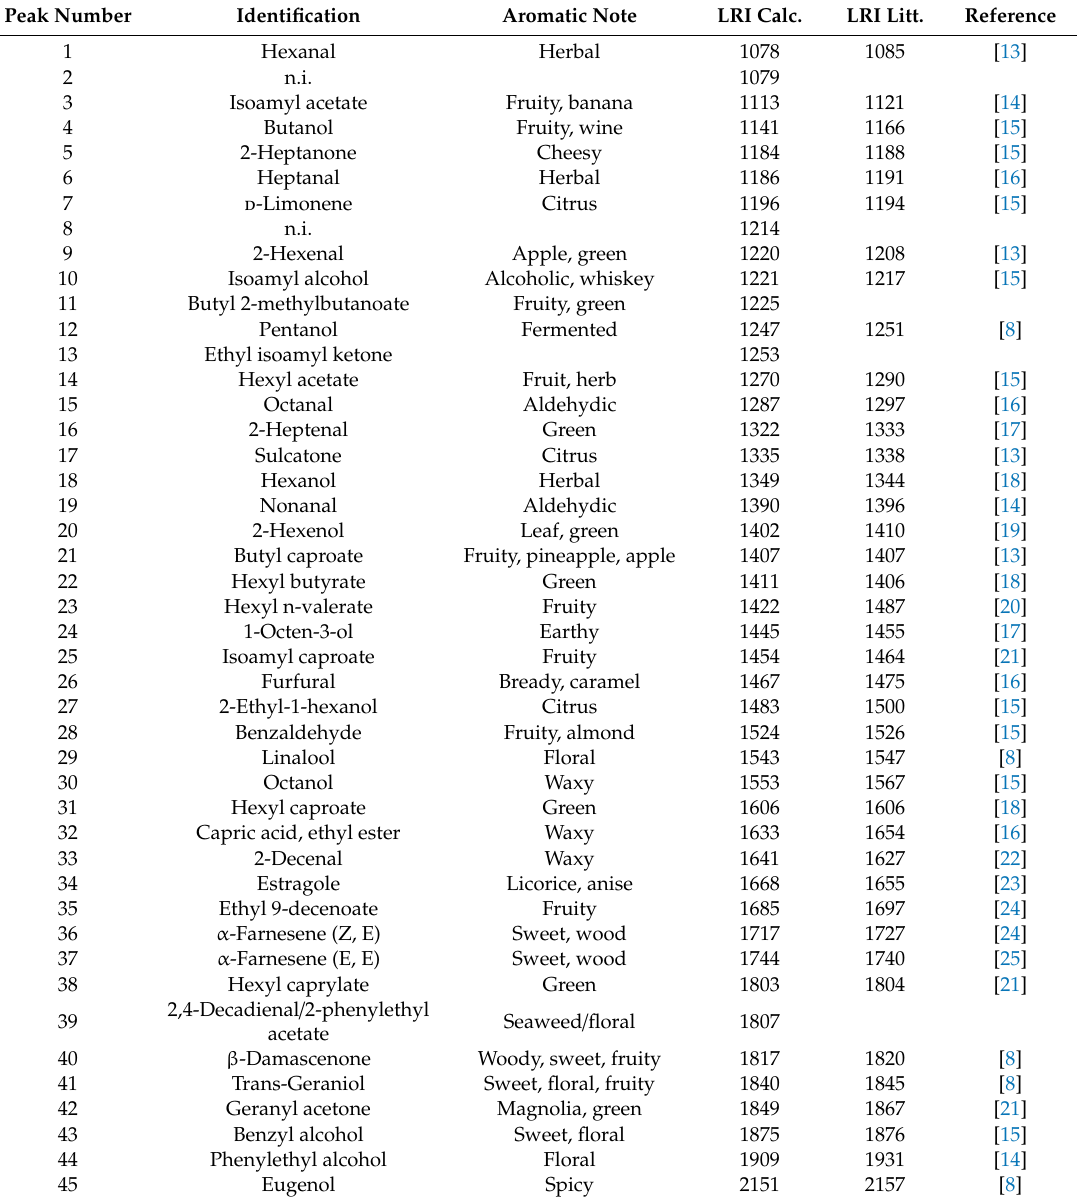
Table 1. Volatile compounds characteristic of apple pomace. For each volatile compound aromatic note, calculated and tabulated linear retention indices (LRIs) and references are